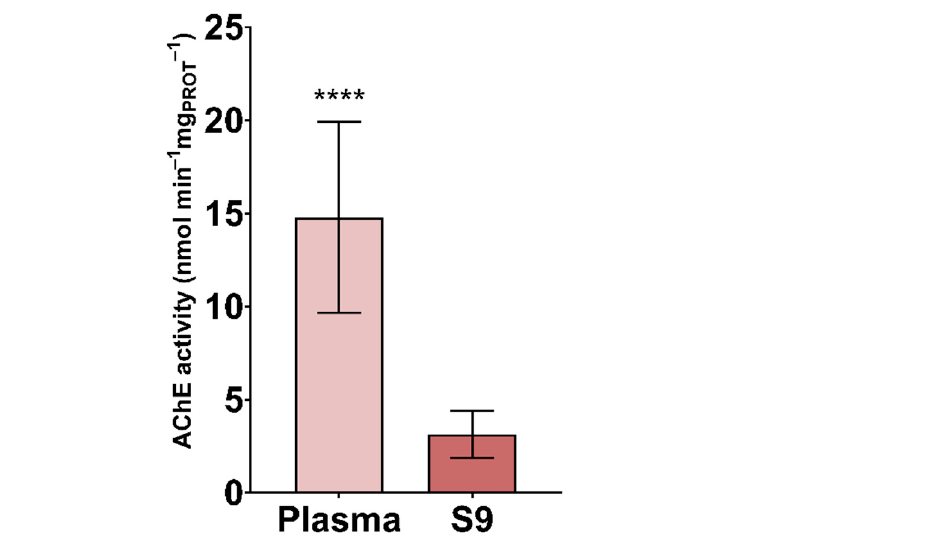
Figure 1. Specific activity of acetylcholinesterase (AChE) in plasma and S9 (nmol min − 1 mg PROT − 1 ) of white stork ( C. ciconia ) nestlings ( n = 16), presented as the mean ± SD. Statistical difference is indicated with **** (Welch’s t -test, p < 0.0001).